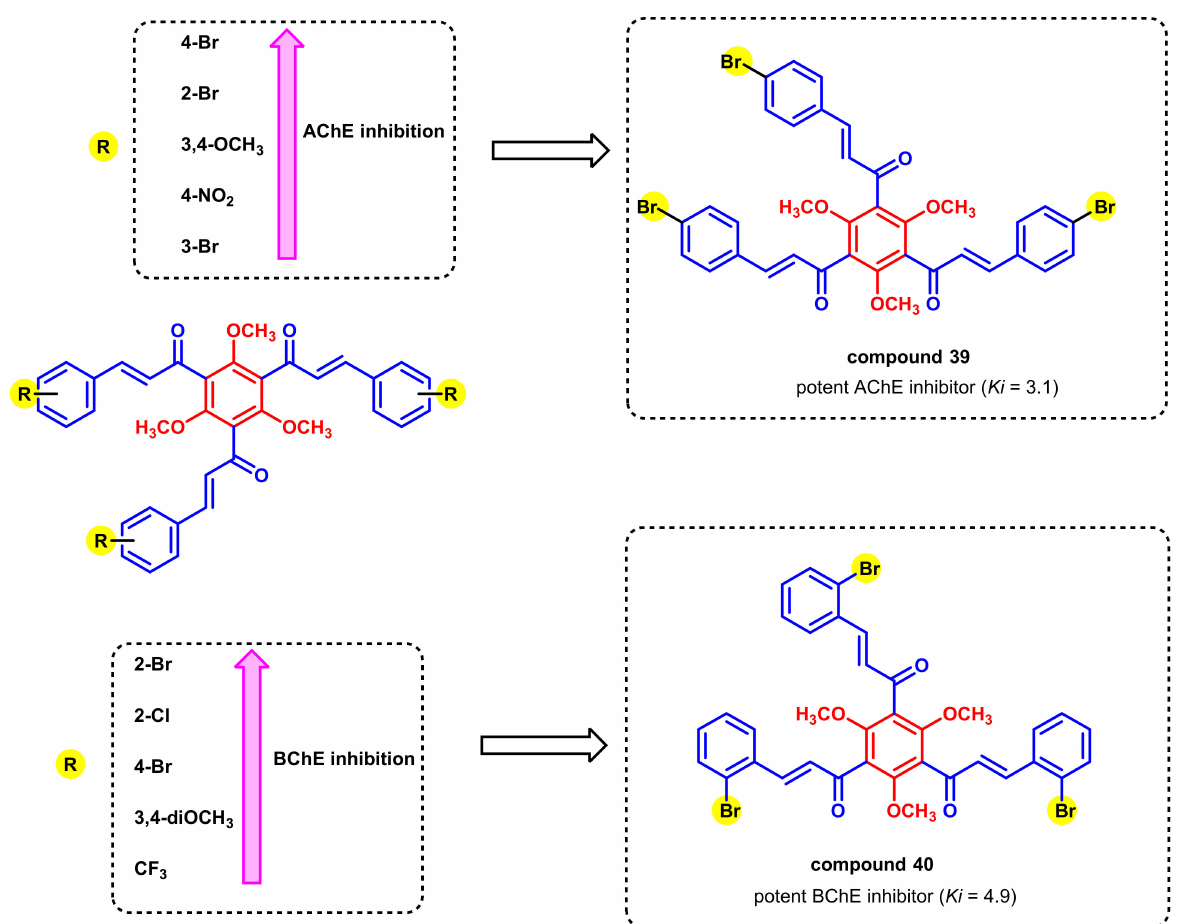
Figure 36. Chemical structures of tris-chalcone derivatives.